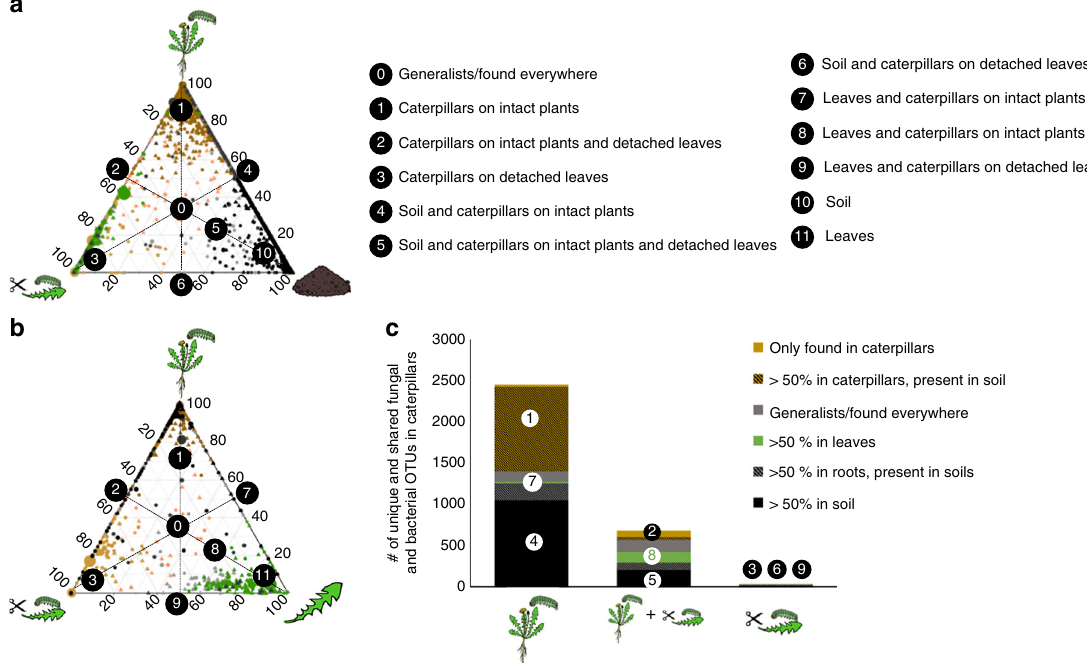
Fig. 2 Bacterial and fungal OTUs shared among caterpillars, plants and soil. a , b Ternary plots of OTUs found in caterpillars. Each symbol represents a single OTU; circles represent bacterial OTUs and triangles fungal OTUs. Only OTUs found in at least 10% of the samples are included in the fi gure. The size of each symbol represents its relative abundance (weighted average) and its color the compartment where it is primary found. Green depicts OTUs found >50% in leaves, brown depicts OTUs found >50% in caterpillars (dark brown OTUs in caterpillars on intact plants and light brown on detached leaves), black depicts OTUs found >50% in soil, grey OTUs found >50% in roots. Grey symbols represent general OTUs found in all compartments. The position of each symbol represents the contribution of the indicated compartments to the total relative abundance. The 50% lines are drawn in the fi gure and most important compartments are marked with numbers (0 – 9). a Depicts OTUs shared between soil (right side), caterpillars on intact plants (top) and caterpillars on detached leaves (left) and b depicts OTUs shared between plants (right), caterpillars on intact plants (top) and caterpillars on detached leaves (left). c The total number of unique and shared OTUs of caterpillars on intact plants and caterpillars on detached leaves. Both fungi and bacteria are included in the fi gure and their identity on the phylum/class level is shown in Supplementary Fig. 6. The color of the compartment where the OTUs are predominantly found and the corresponding region in panel a and b is also